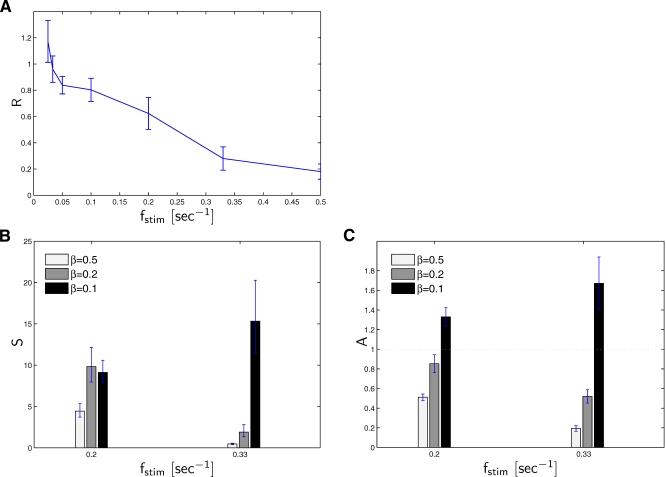
Experimental Results from Neural Cultures Developing In Vitro(A) Frequency dependent adaptation. A total of 19 networks were stimulated at different frequencies (0.02–0.5 s−1). At each frequency the networks were stimulated for 900 s, long enough to reach steady state. Responsiveness is defined as the mean number of spikes detected in a network within 150 ms after a stimulus. Steady-state responsiveness was computed by averaging over the last 6 responses following repetitive stimulation at a given frequency f
stim. The result was normalized to the networks' initial responsiveness to produce R as defined in Equation 3. Error bars mark ±SEM.(B, C) Dual site stimulation. Stimuli were applied at two stimulation rates (once every 5 s and once every 3 s) and in three patterns: 1:4, 1:9, and 1:1 (sites A and B, respectively; i.e., β = 0.2, 0.1, and 0.5, respectively) in a paradigm similar to that described in [14] (total of 6 different stimulation epochs). Responsiveness is defined as the total number of spikes in the network within 150 ms after a stimulus. The network was allowed 15 min of recovery between epochs.(B) Dependence of selectivity (as defined in Equation 13).(C) Amplification (as defined in Equation 14) on stimulation frequencies and ratios. Steady-state responsiveness was computed by averaging over all responses to a site in the last half of each epoch. These were normalized to the un-adapted response, defined as the maximal response in the first 30 s of each epoch (this definition was used to overcome rapid transients in the initial response). Error bars in (B) mark Smin and Smax (see Materials and Methods, Equation 28). Error bars in (C) mark ±SEM (normalized to the un-adapted response).